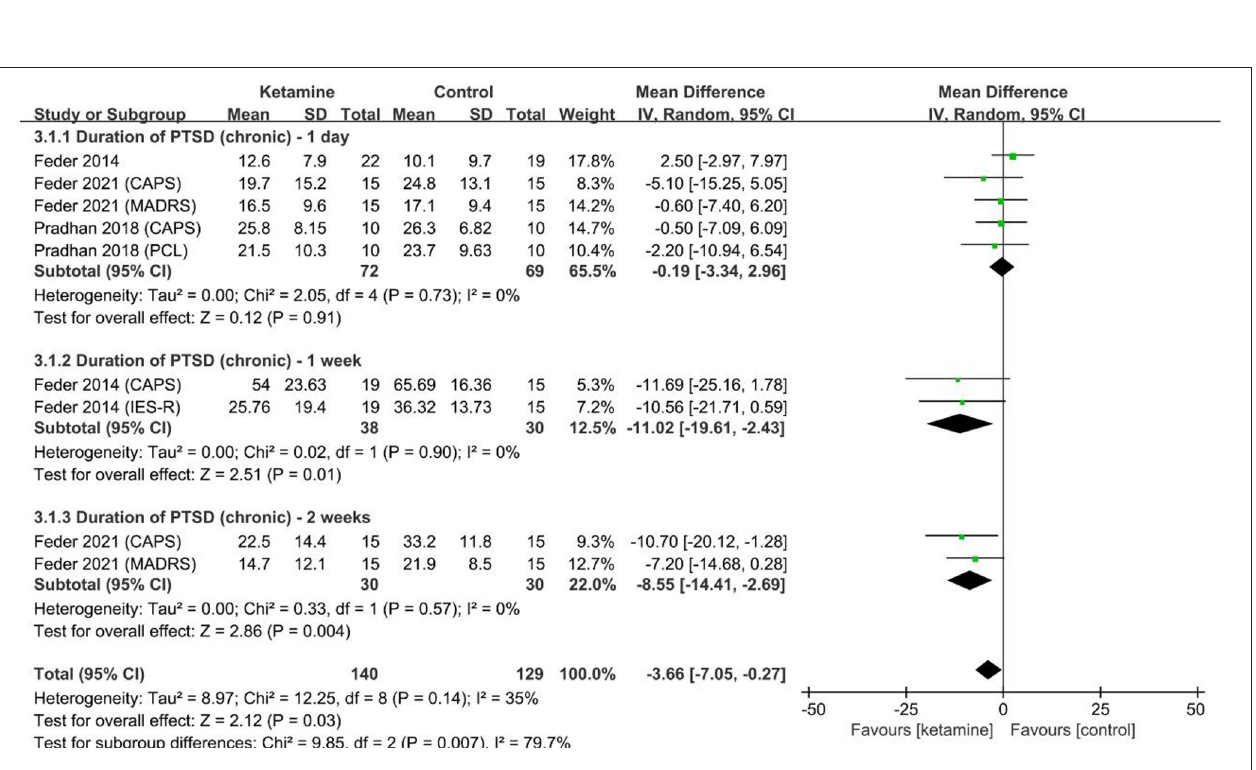
FIGURE 5 | PTSD-scale scores of long duration (chronic, years) patients by ketamine. administration (ketamine vs. control). CAPS, Clinician-Administered PTSD Scale; MADPS, Montgomery-Asberg Depression Rating Scale; IES-R, Impact of Event Scale–Revised score; PCL, PTSD Checklist; IV, inverse variance; SD, standard